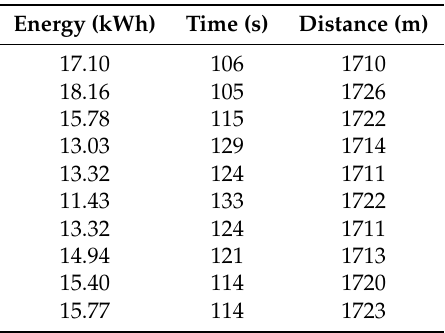
Figure 6. OSP generated with speed constraints. Table 1. OSP energies, times and distances.